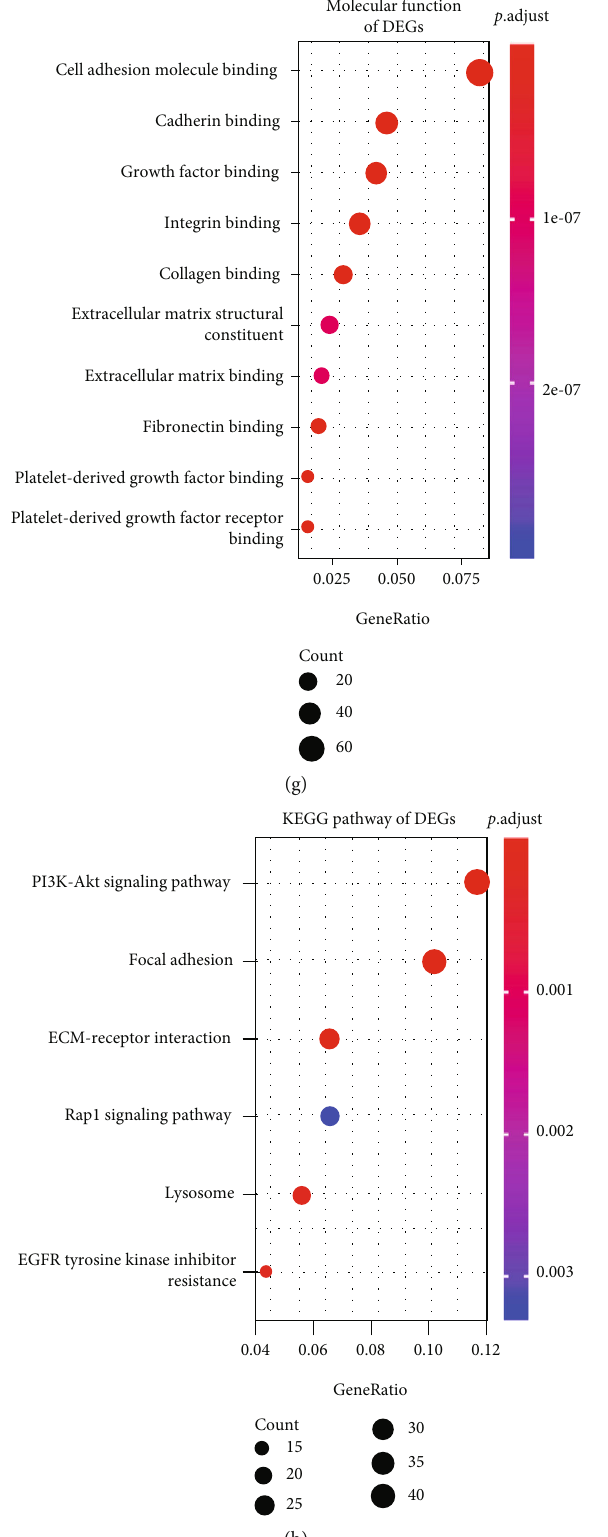
Figure 4: Functional enrichment analysis results of up- and downregulated genes for Ewing ’ s sarcoma. (a) Biological processes; (b) cell component; (c) molecular function; and (d) KEGG for upregulated genes. (e) Biological processes; (f) cell component; (g) molecular function and (h) KEGG for down-regulated